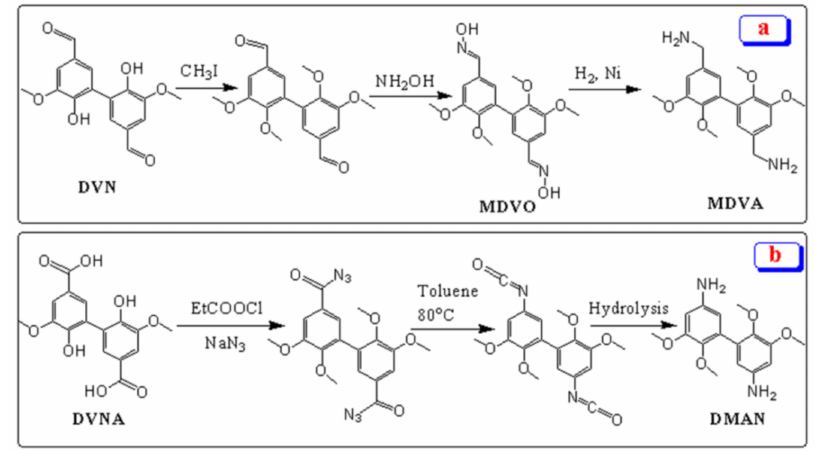
Figure 11. An illustration reaction scheme of ( a ) MDVA, and ( b )